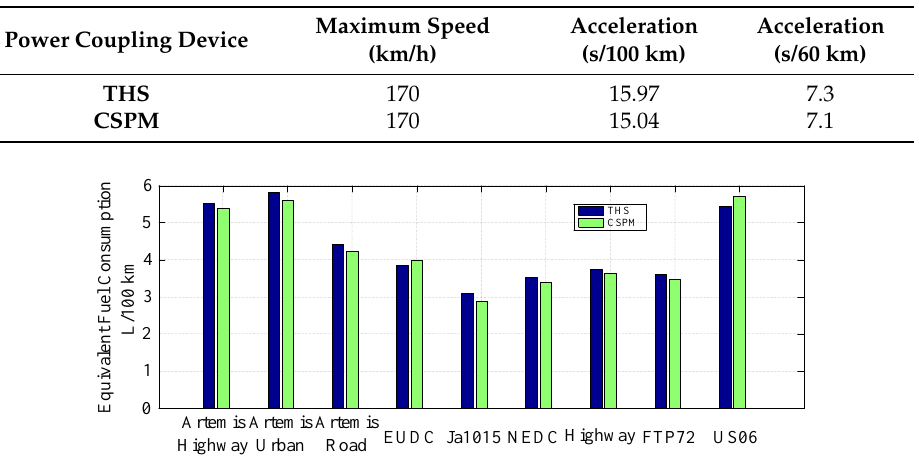
Table 3. The dynamic performances of the HEVs.